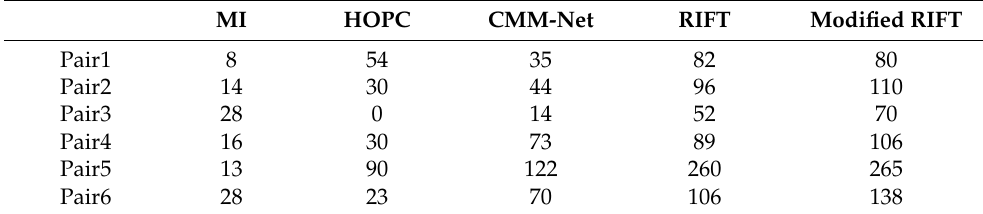
Figure 11. The comparison of different registration methods (NCC, MI, SIFT, RIFT, modified RIFT). Table 3. The number of correct corresponding points of different registration methods.